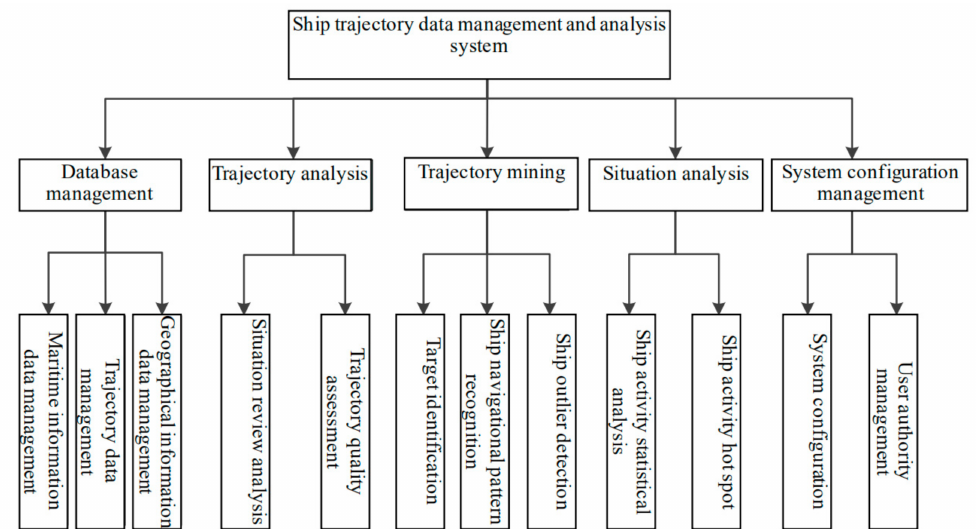
Figure 1. Main functional modules of